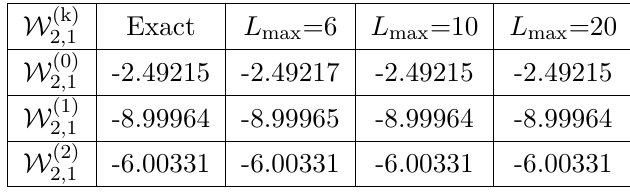
calculated directly using (A.3) in (2.4), (2.5), (2.6), compare with calculated using Table 5 . W ( k ) 2 , 1 formula (2.16) and (A.10). We have truncated the k -sum to k